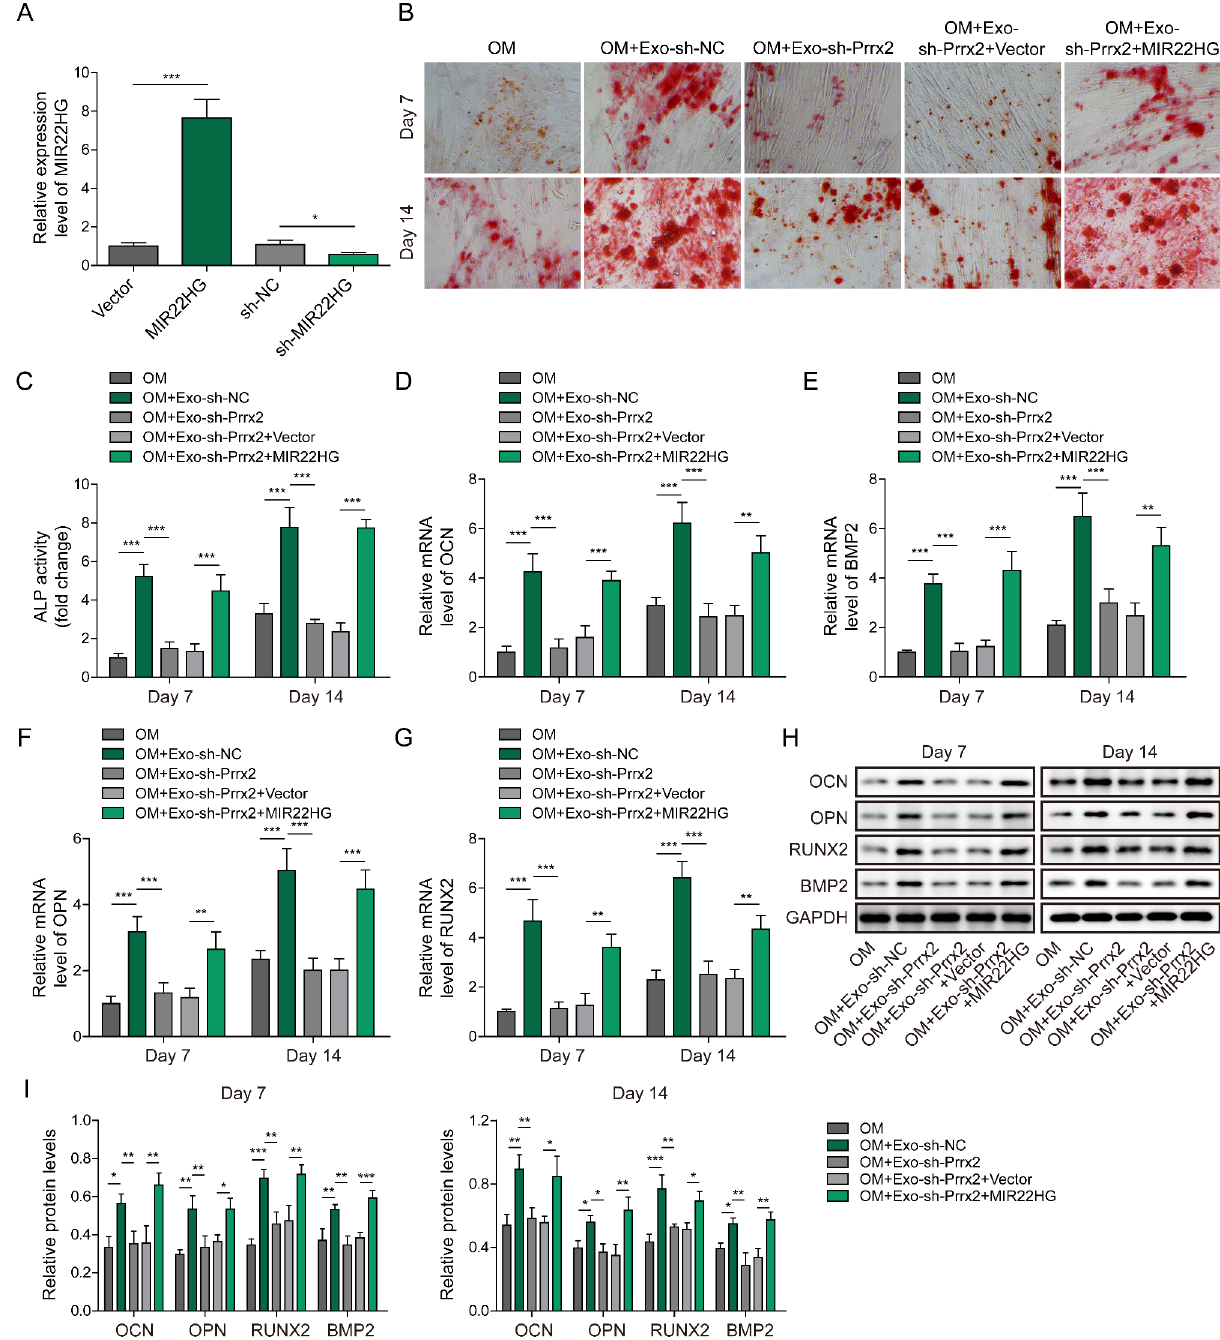
Fig. 4 Silencing of Prrx-2 in myoblast-derived exosomes represses osteogenic differentiation via inhibiting MIR22HG expression. (A) MIR22HG expression in BMSCs fromVector, MIR22HG, shNC and shMIR22HG groups was assessed by qRT-PCR. (B) The matrix mineralization of BMSCs from OM, OM + Exo-shNC, OM + Exo-shPrrx-2, OM + Exo-shPrrx-2 + vector, OM + Exo-shPrrx-2 + MIR22HG groups was determined by Alizarin Red staining. (C) The ALP activity of BMSCs from different groups. (D-I) The mRNA and protein level of OCN, BMP2, OPN, and RUNX2 was analyzed by qRT-PCR and Western blotting. * P < 0.05, ** P < 0.01 and *** P <